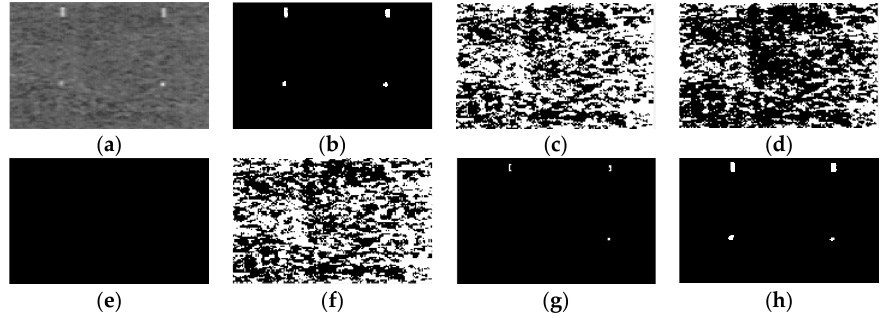
Figure 6. Image2 and its segmentation results: ( a ) #image2, ( b ) ground-truth, ( c ) Otus, ( d ) MRCUT,